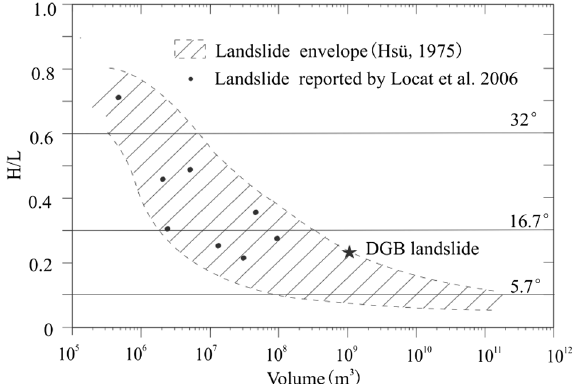
Figure 18. Plot of H/L versus volume for rock avalanches. The lower and upper broken lines represent landslides that show maximum and minimum mobility, respectively, with regards to their volume (modified after Hsü 28